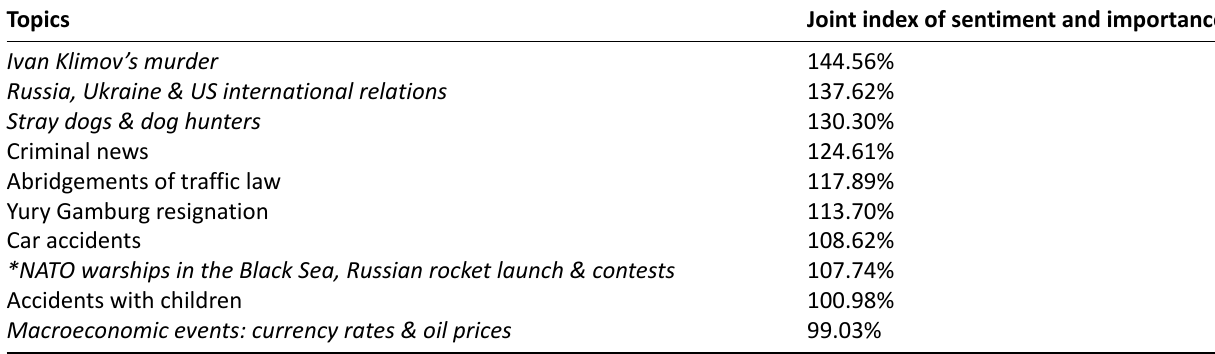
Table 4. Top ten topics ranked jointly by negative sentiment and